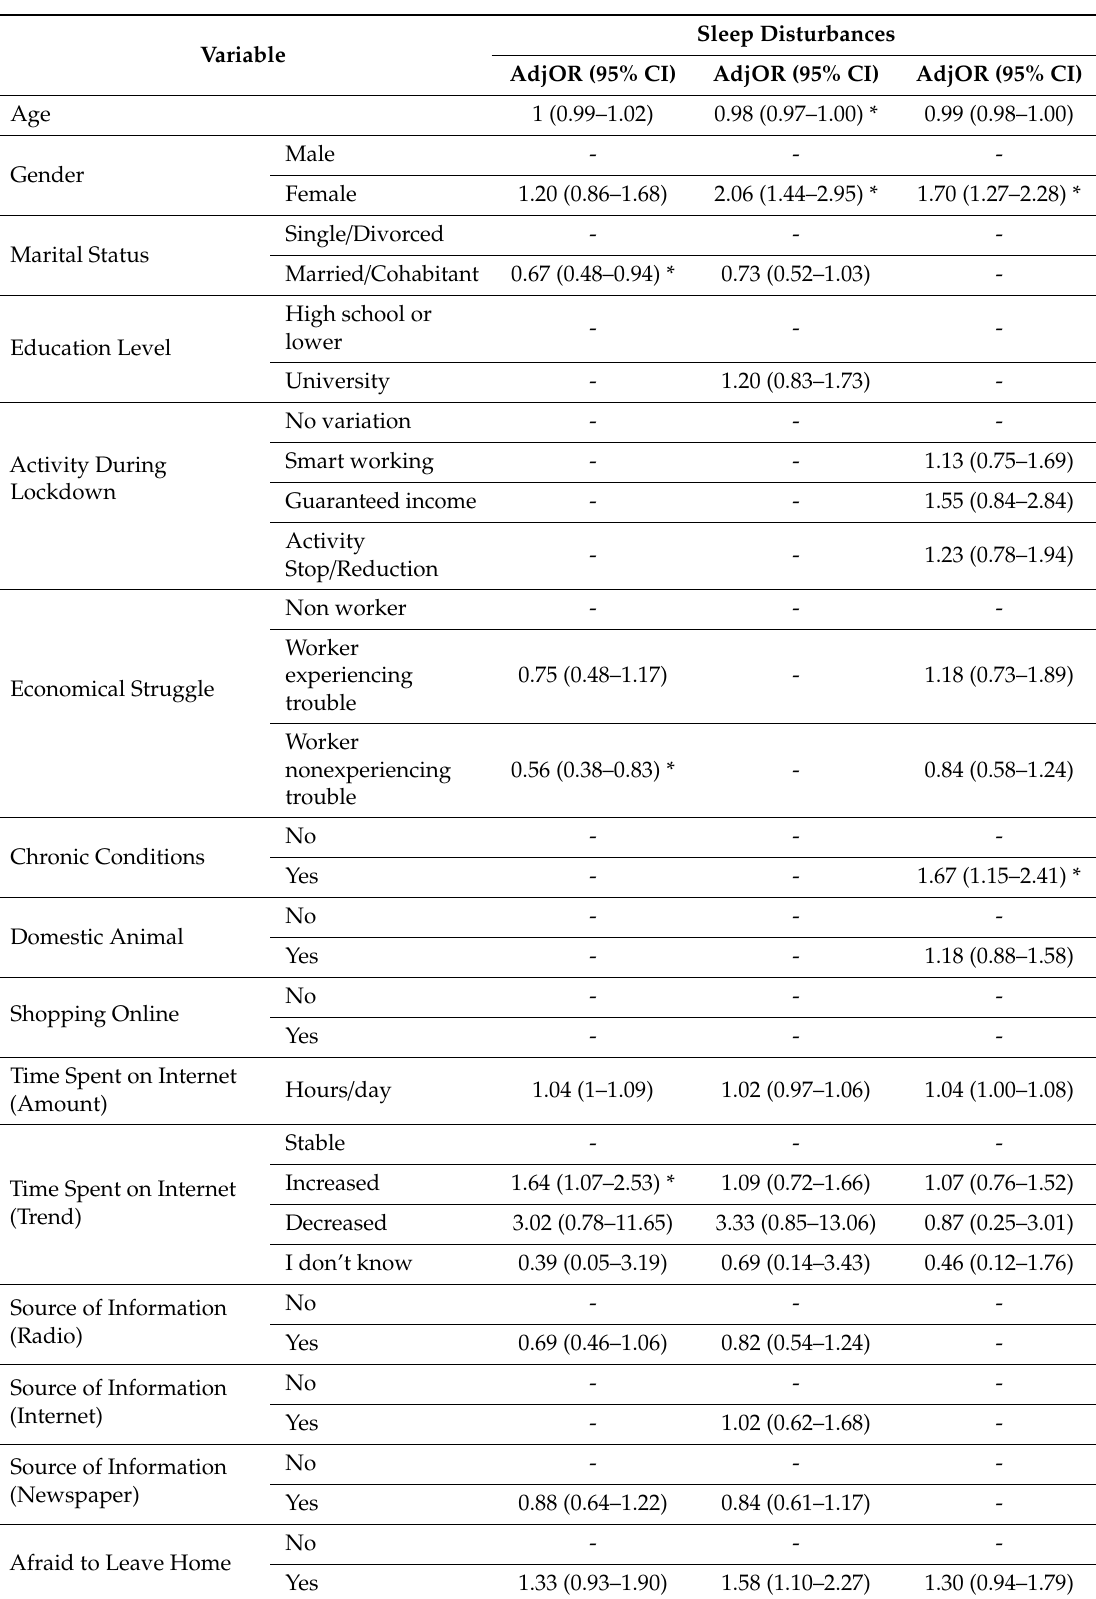
Table 3. Predictors of depression, anxiety and sleep disturbances (AdjOR: Adjusted Odds Ratio; CI: Confidence